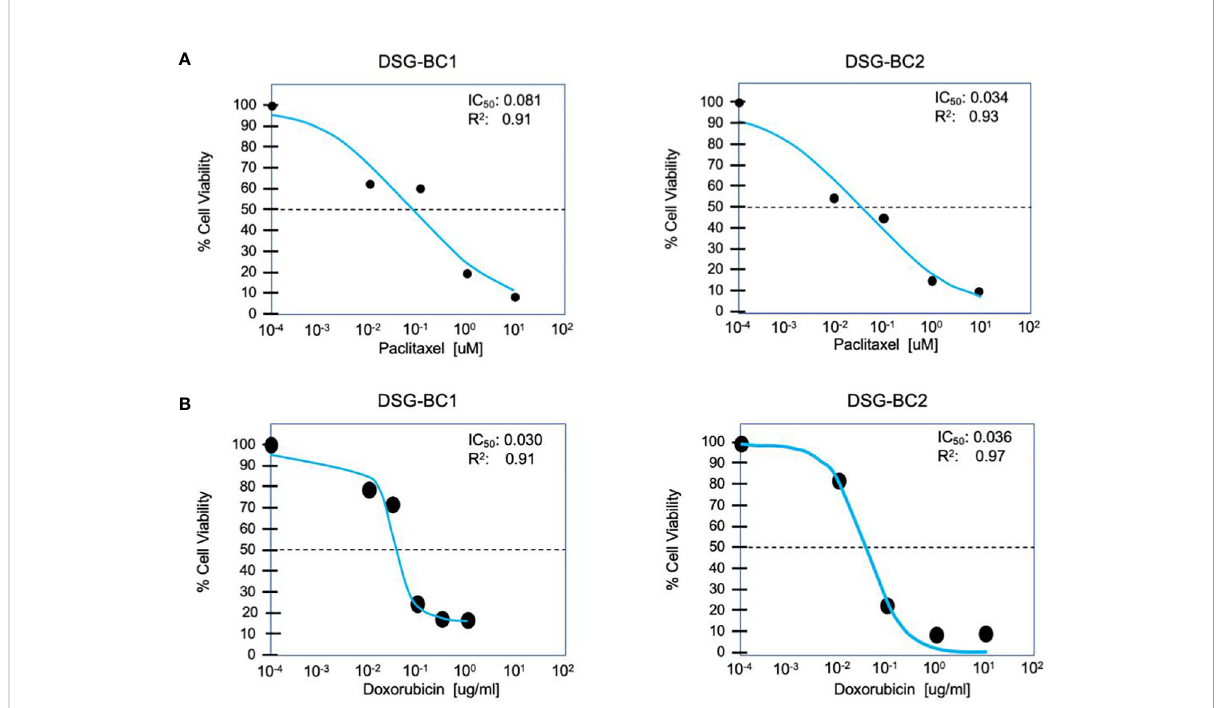
FIGURE 5 Breast cancer cells derived from a patient with obesity display lower chemosensitivity to paclitaxel compared to breast cancer cells derived from a patient with normal weight. Cytotoxicity assay for paclitaxel (A) and doxorubicin (B) after treatment for 48 h. n =